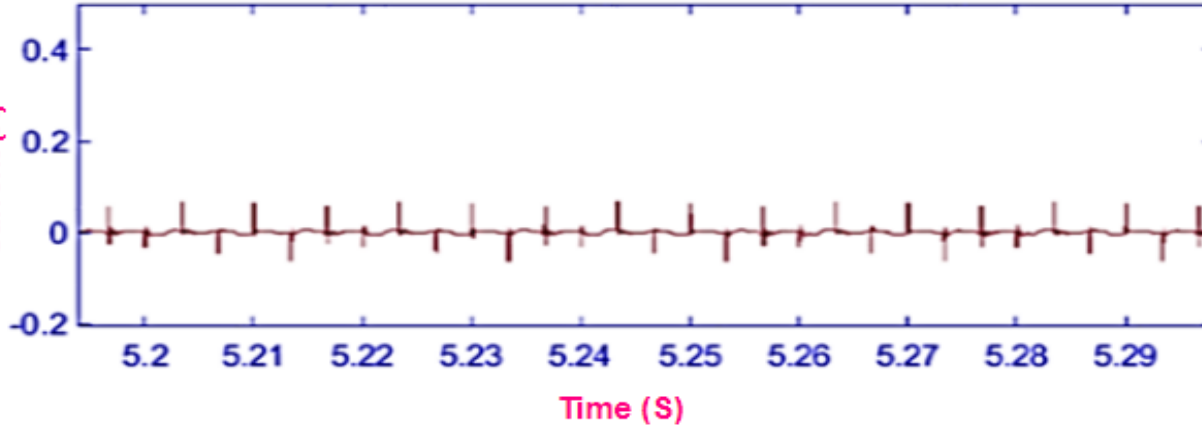
Figure 27. Circulating bearing current of modified ANN ‐ based sensor ‐ less induction motor with modified cascaded H ‐ bridge inverter.